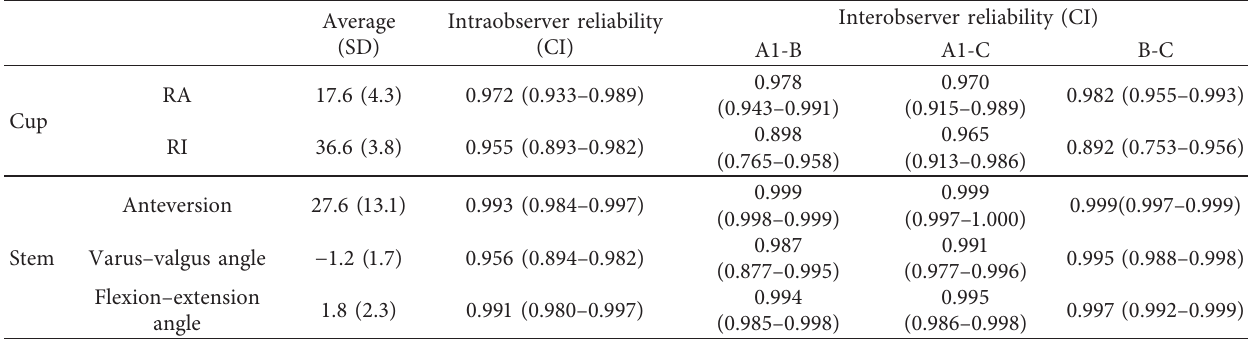
Table 3: Interobserver and intraobserver reliabilities for alignment measurement.